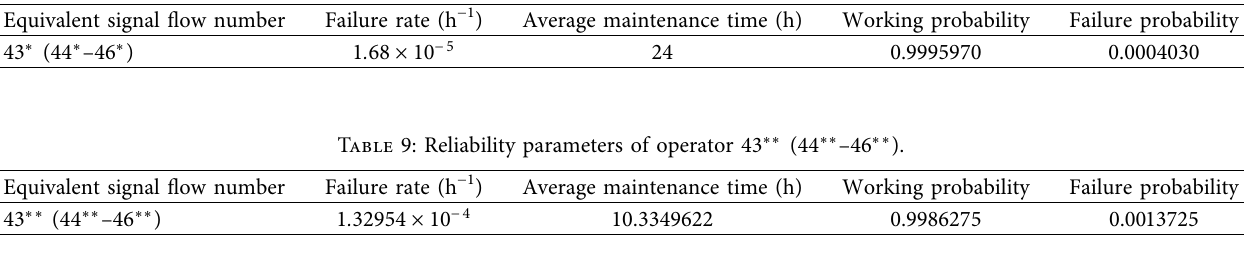
Table 8: Reliability parameters of operator 43 ∗ (44 ∗ –46 ∗